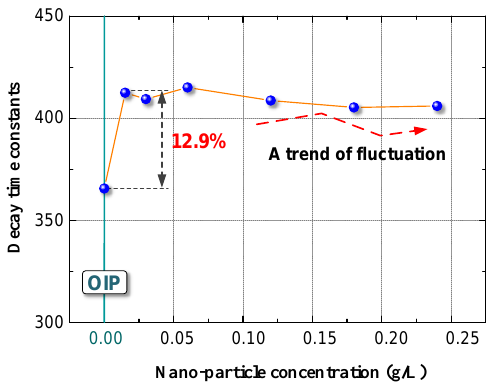
Figure 16. Decay time constants of the OIP and NOIP samples.